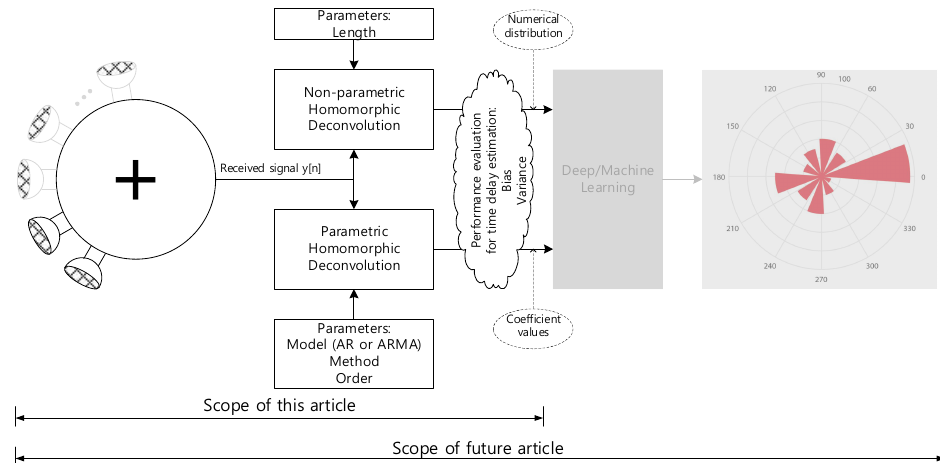
Figure 2. Overall methodology for vehicle sound source localization system. Note that the gray area will be investigated in the future article.